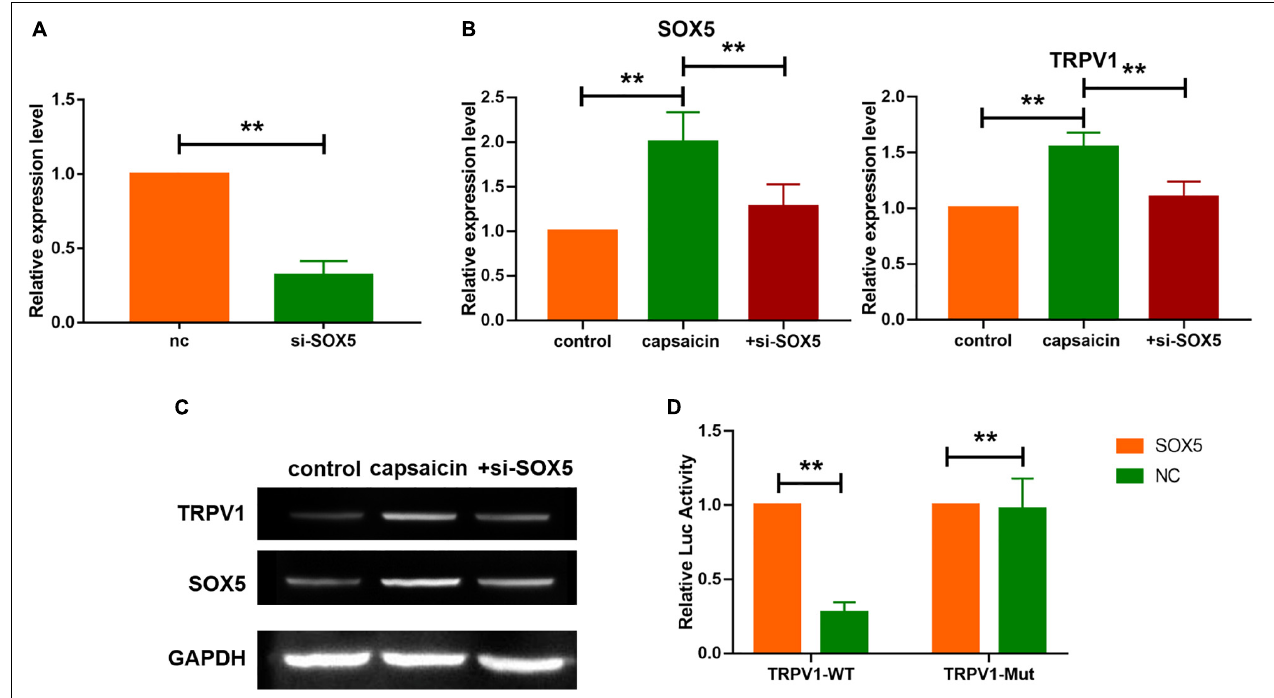
FIGURE 4 | Sox5 mediated the expression of TRPV1 in neuronal cells in response to capsaicin administration. (A) mRNA level of SOX5 in neuronal cells. Data are mean ± SEM; two-tailed t -test was used for statistical analysis. (B,C) Upregulation of TRPV1 was inhibited after si-SOX5 transfection. Data are mean ± SEM; one-way ANOVA was used for statistical analysis. (D) SOX5 induced the expression of TRPV1 gene, as determined using luciferase assay. Data are mean ± SEM; one-way ANOVA was used for statistical analysis. ** P < 0.01; n =